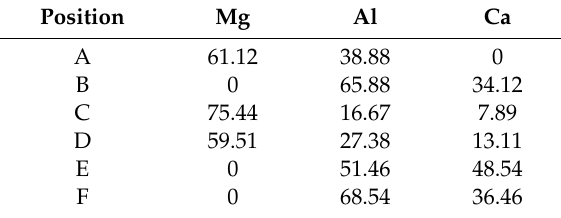
Table 2. EDS result corresponding to di ff erent positions in Figure 4. (mole fraction, %).